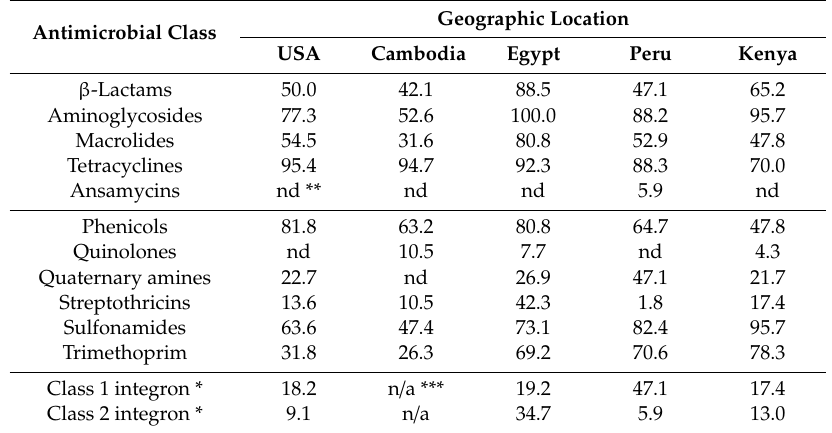
Table 6. Percentage of E. coli , Shigella spp., and Salmonella isolates harboring at least one ARD to each of 11 classes of antimicrobial